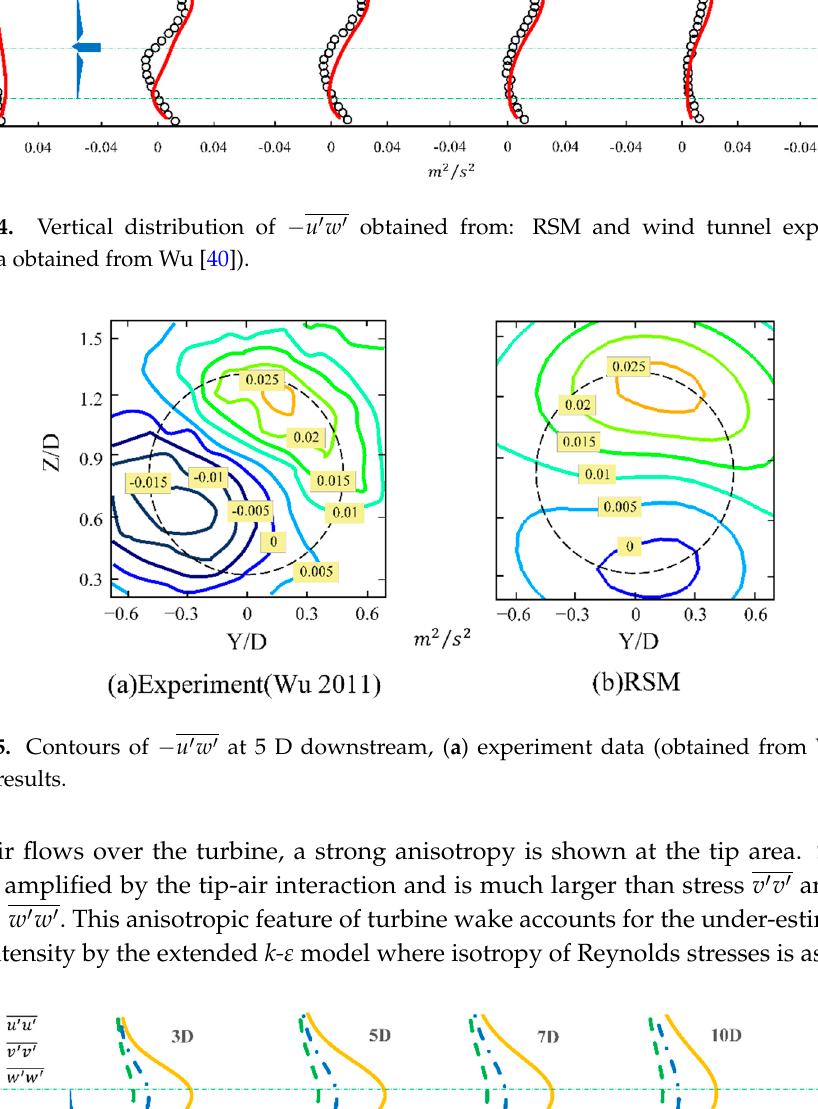
Figure 16. Vertical distribution of (cid:1873) (cid:4593) (cid:1873) (cid:4593) (cid:3364)(cid:3364)(cid:3364)(cid:3364)(cid:3364)(cid:3364) , (cid:1874) (cid:4593) (cid:1874) (cid:4593) (cid:3364)(cid:3364)(cid:3364)(cid:3364)(cid:3364)(cid:3364) and (cid:1875) (cid:4593) (cid:1875) (cid:4593) (cid:3364)(cid:3364)(cid:3364)(cid:3364)(cid:3364)(cid:3364)(cid:3364) simulated by RSM.